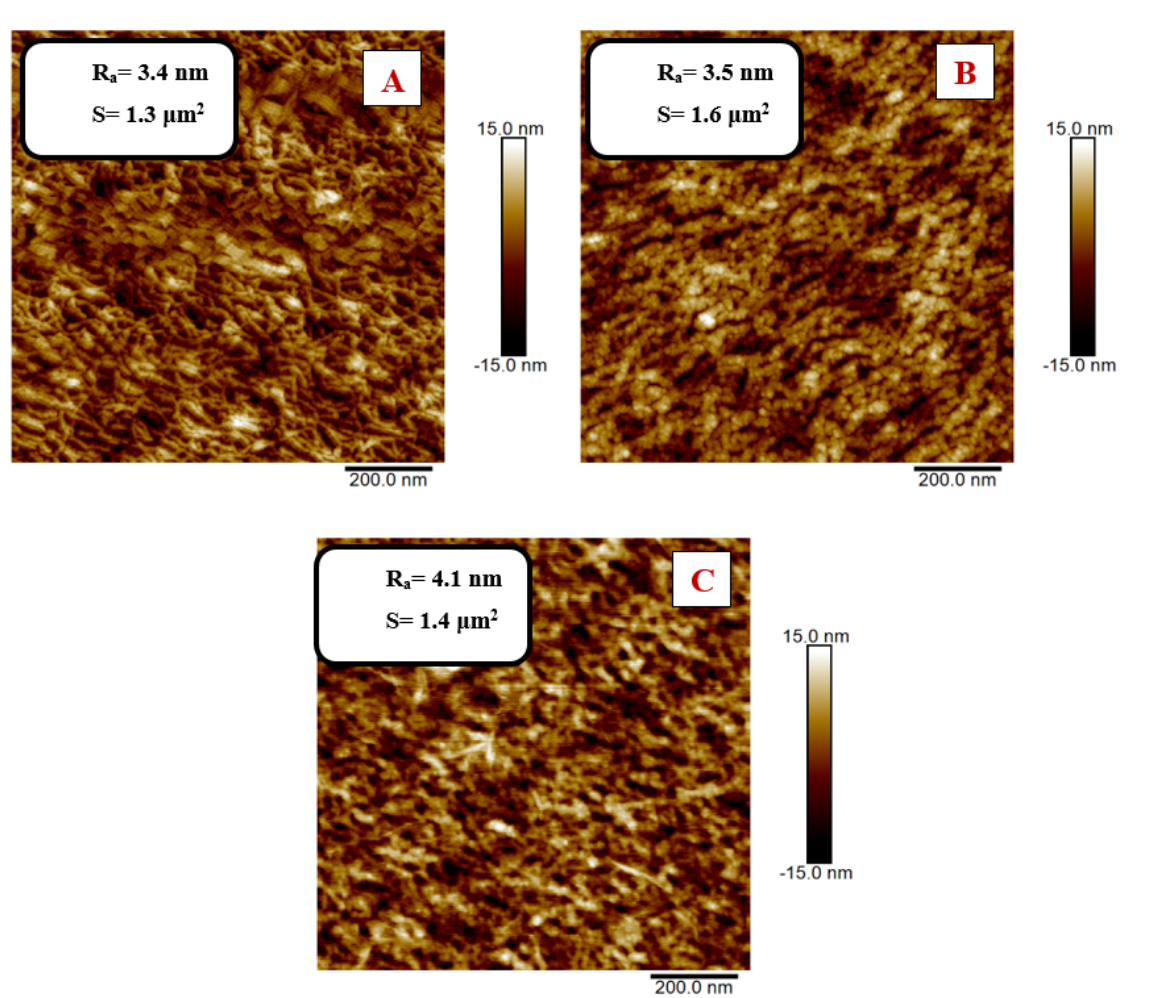
Figure 12. Two-dimensional AFM images of PEN that was modified using plasma for 400 s at 8 W power: ( A ) non-grafted sample; ( B ) grafted in AuNP/NALC (1.5 g)/H 2 O (100 mL)/PEG solution, AuNP deposition time 600 s; ( C ) grafted in AuNP/NALC (1.5 g)/H 2 O (100 mL)/PEG solution, AuNP deposition time 900 s.